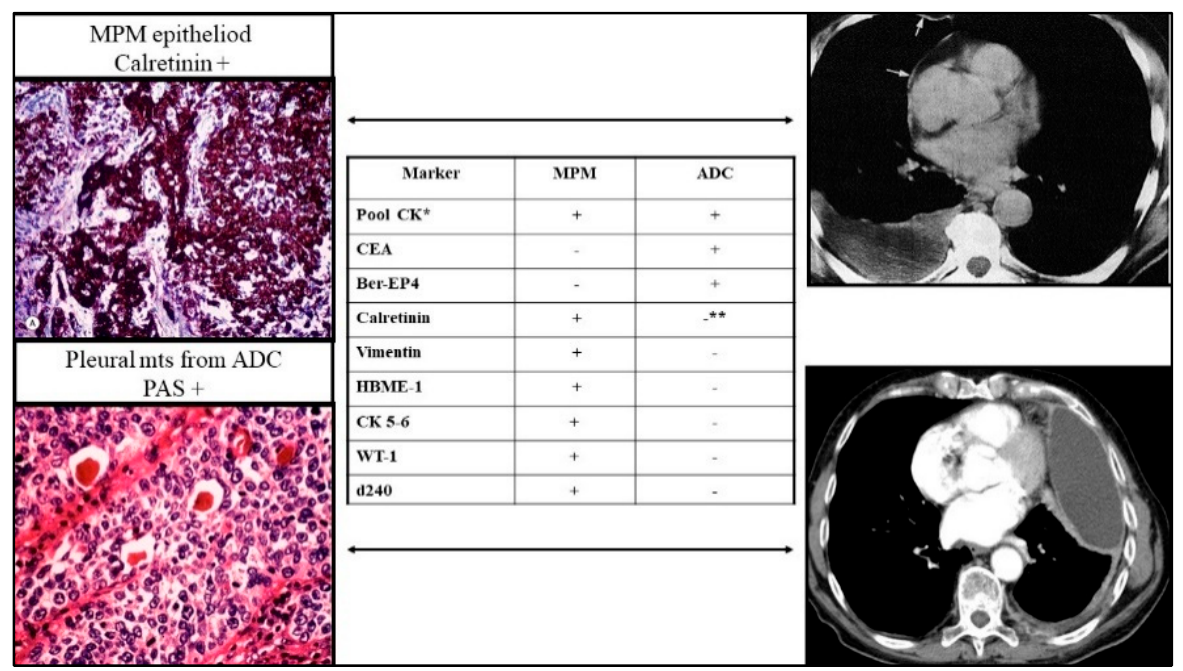
Figure 1. Immunohistochemistry workup in case of pleural masses and suspect of MPM. The study should include the expression of vimentin 8, TTF1, p40, calretinin, WT-1, D240, citokeratin 5/6, vimentin, S100, BER-EP4, CEA, CD31, CD34, desmin, and myogenin D1. The most relevant differential diagnosis regards MPM (e.g., calretinin positive) vs. pleural metastases from lung cancer (e.g., PAS-positive staining in case of adenocarcinoma -ADC); in some cases, results might not solve the origin of neoplastic cells proliferating into the pleural space. Moreover, differential diagnosis requires the exclusion of undifferentiated MPM, the presence of a small/dormant lung primary carcinoma, a pleural localization of melanoma (expression of S100), rhabdomyosarcoma (expression of desmin and myogenin D1), and angiosarcoma (expression of CD31, CD34), ectopic lung epithelial cells which undergo a malignant transformation, or of epithelial cancer from an unknown primary site of origin. **= possible, * = rare